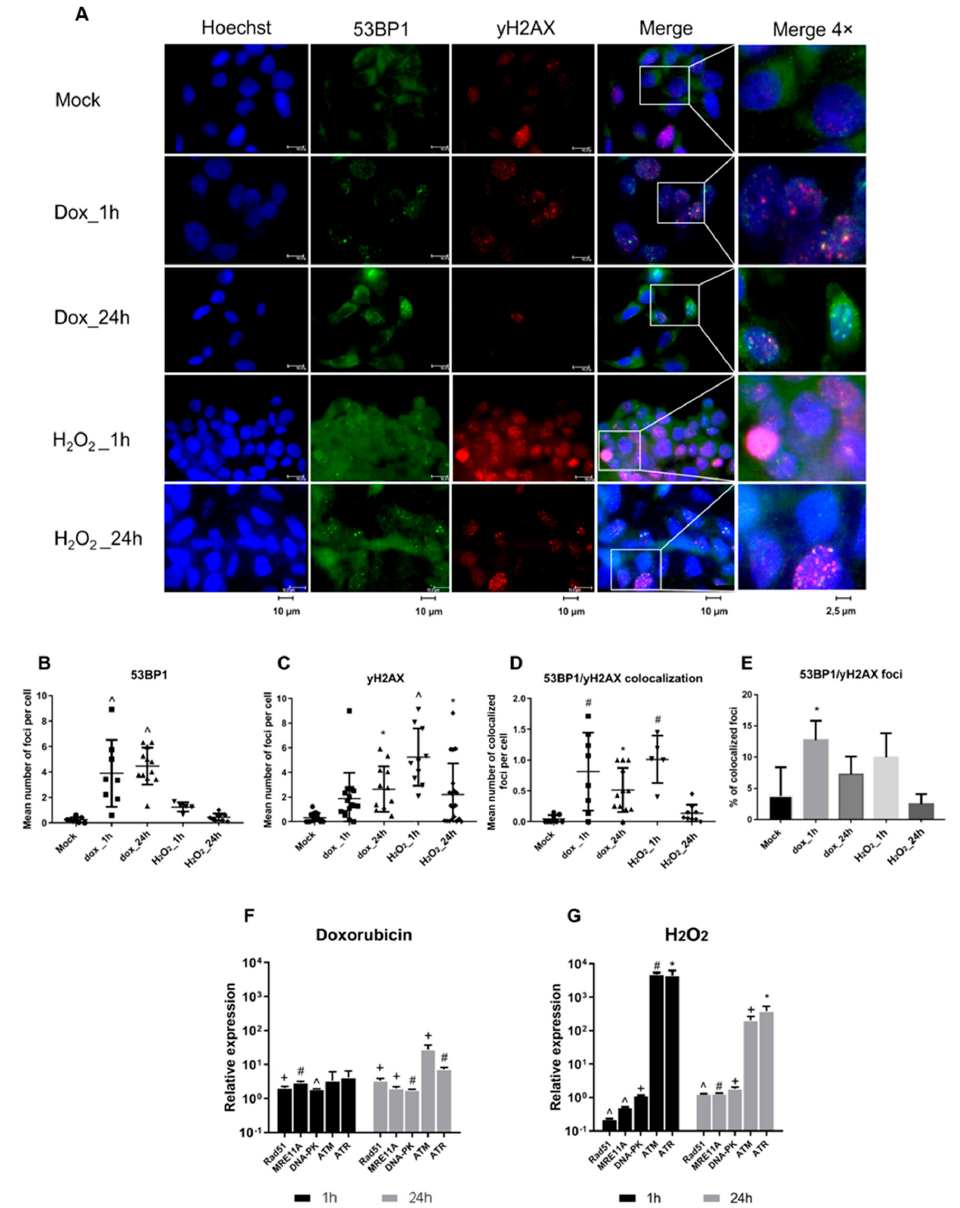
Figure 2. Study of DDR in response to doxorubicin and H 2 O 2 treatment in HBV replication model. ( A ) Detection by immunofluorescence of the formation of 53BP1 (green) and yH2AX (red) foci 1 h and 24 h after treatment with doxorubicin (dox) or H 2 O 2 . Cell nuclei were counterstained with Hoechst33342 dye (blue). Quantitative analysis of ( B ) 53BP1 and ( C ) yH2AX foci, ( D ) the mean number of all co-localized 53BP1 / yH2AX foci per cell, and ( E ) percentage of co-localized 53BP1 / yH2AX foci calculated as the ratio of co-localized foci to the total number of both types of foci. Expression of DDR factors 1 h and 24 h post ( F ) doxorubicin and ( G ) H 2 O 2 treatments. Asterisks indicate statistically significant differences in means compared to control. * p < 0.05, + p < 0.01, # p < 0.001, ^ p < 0.0001.